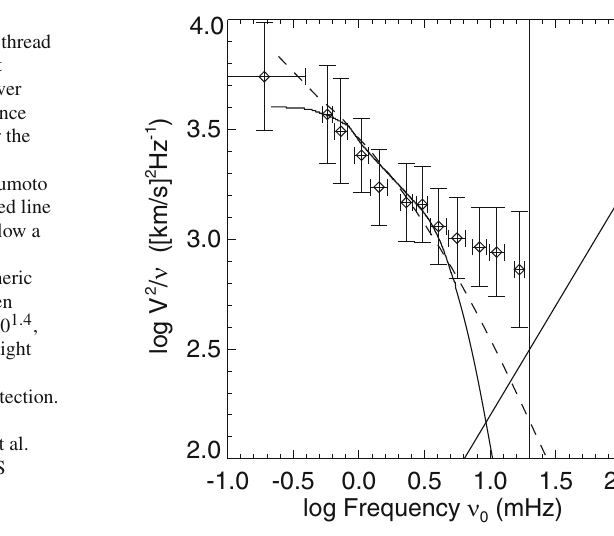
Fig. 8 Hinode/SOT H α observation of transverse thread oscillations in a quiescent prominence. Velocity power spectrum for the prominence threads (symbols) and for the horizontal photospheric motions: solid line (Matsumoto and Kitai 2010) and dashed line (Chitta et al. 2012). To allow a comparison between the prominence and photospheric spectra, the later have been multiplied by 10 1 . 1 and 10 1 . 4 , respectively. The two straight solid lines show the observational limits of detection. Image reproduced with permission from Hillier et al. (2013), copyright by